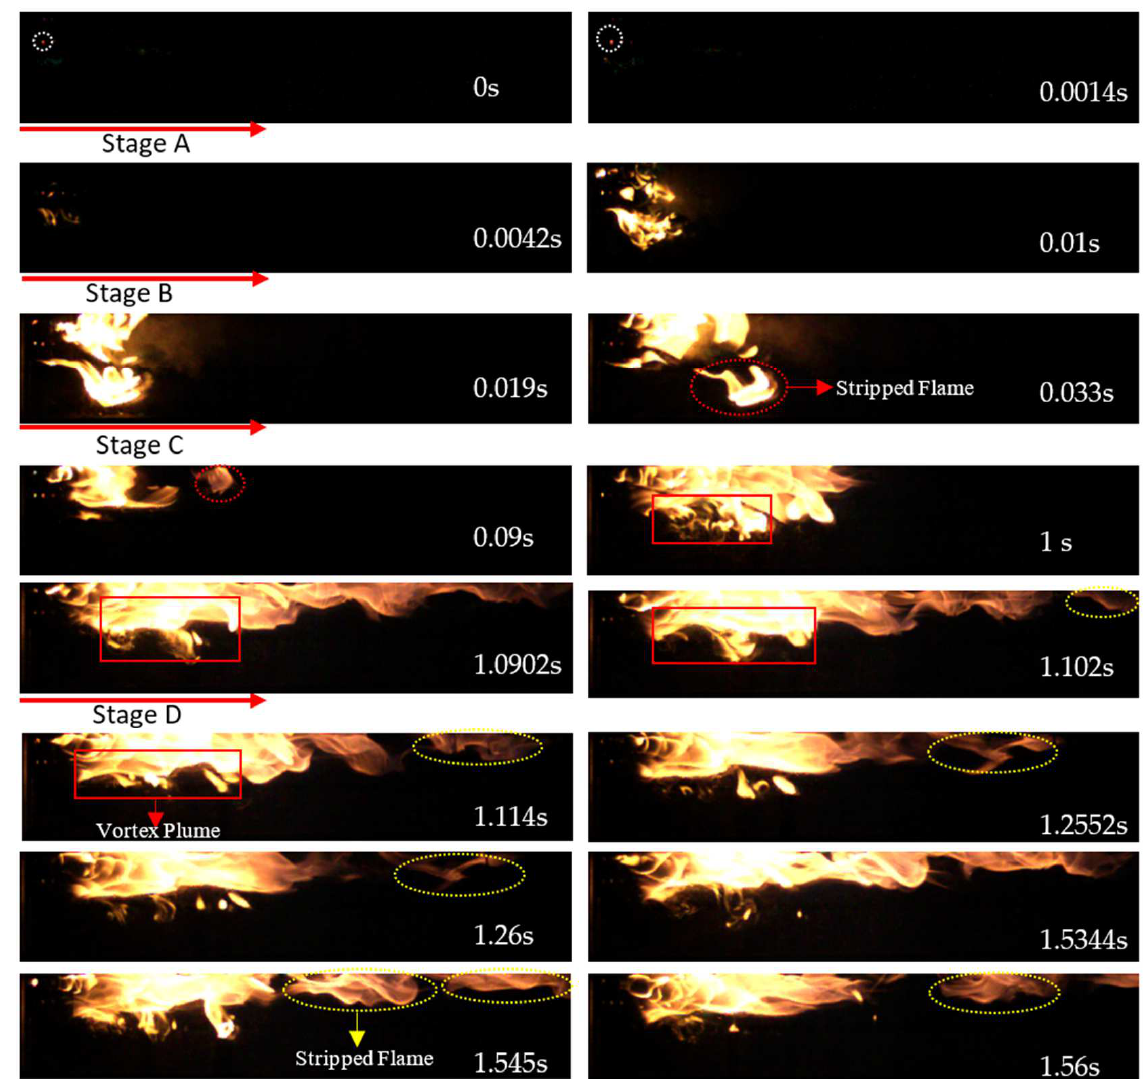
Figure 8. Flame propagation under the air flow velocity of 2.5 m/s and the diesel flow rate of 10.0